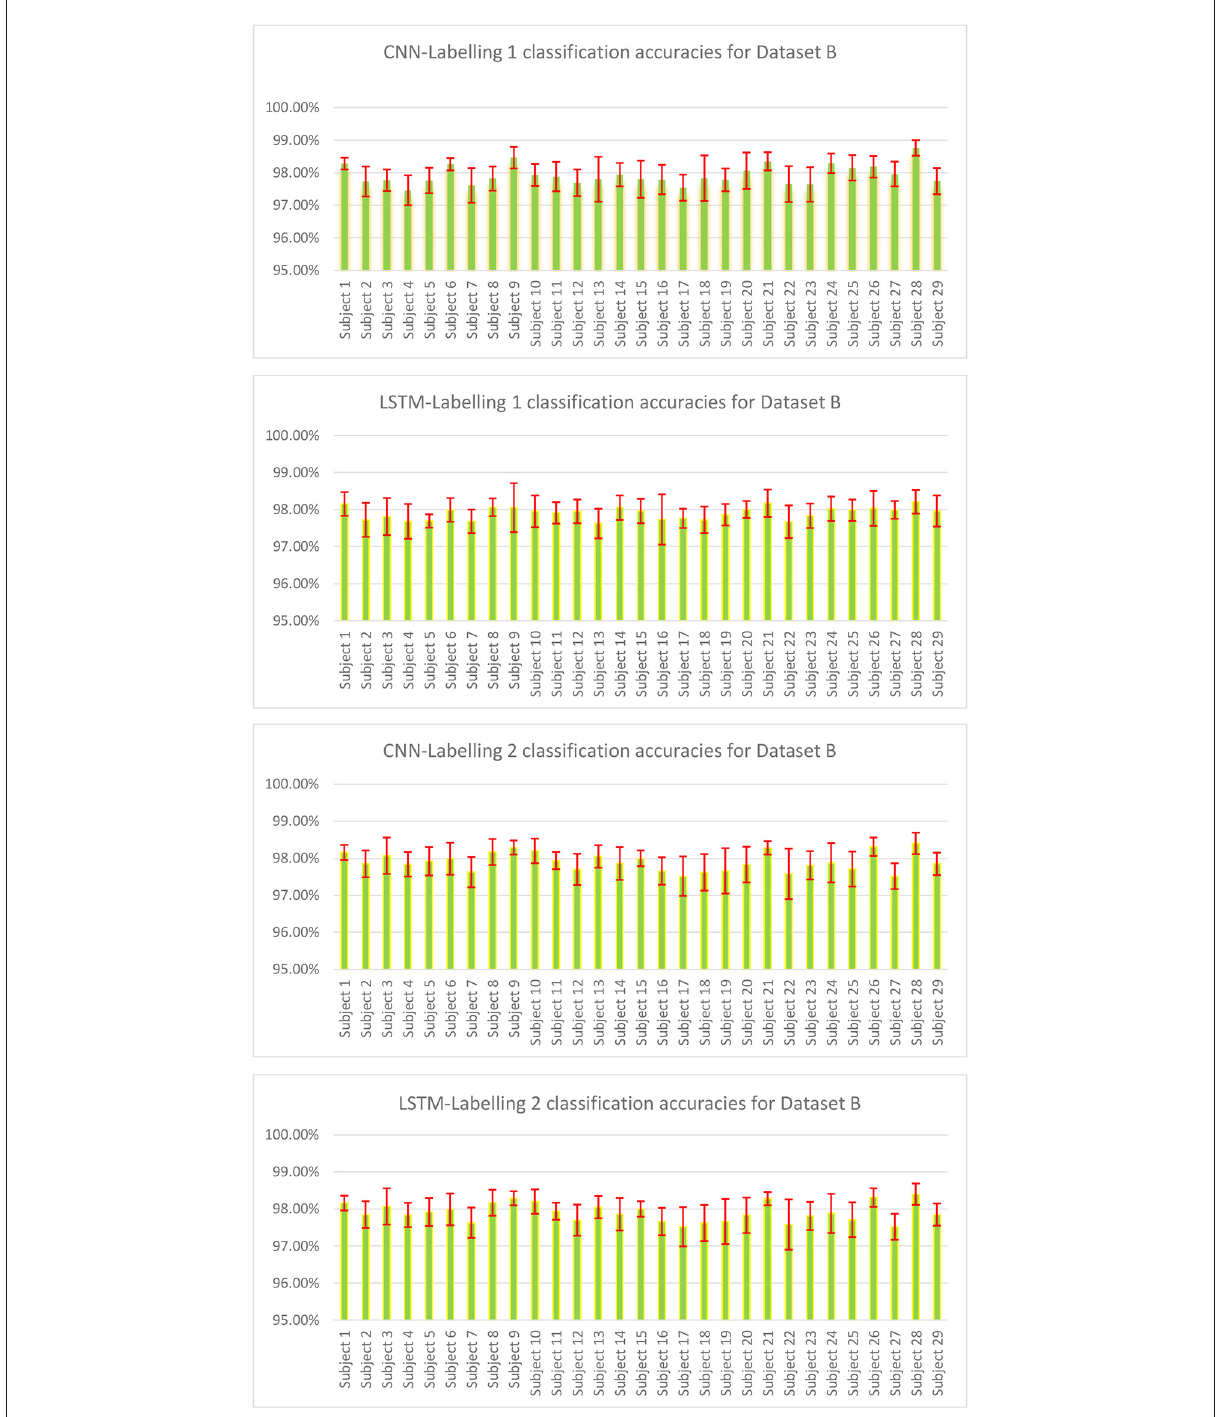
FIGURE12 Classification accuracies of CNN and LSTM model for Dataset B where each subject had three sessions and all three were combined for 10-fold cross-validation, and 5-fold cross-validation was done for combined sessions.